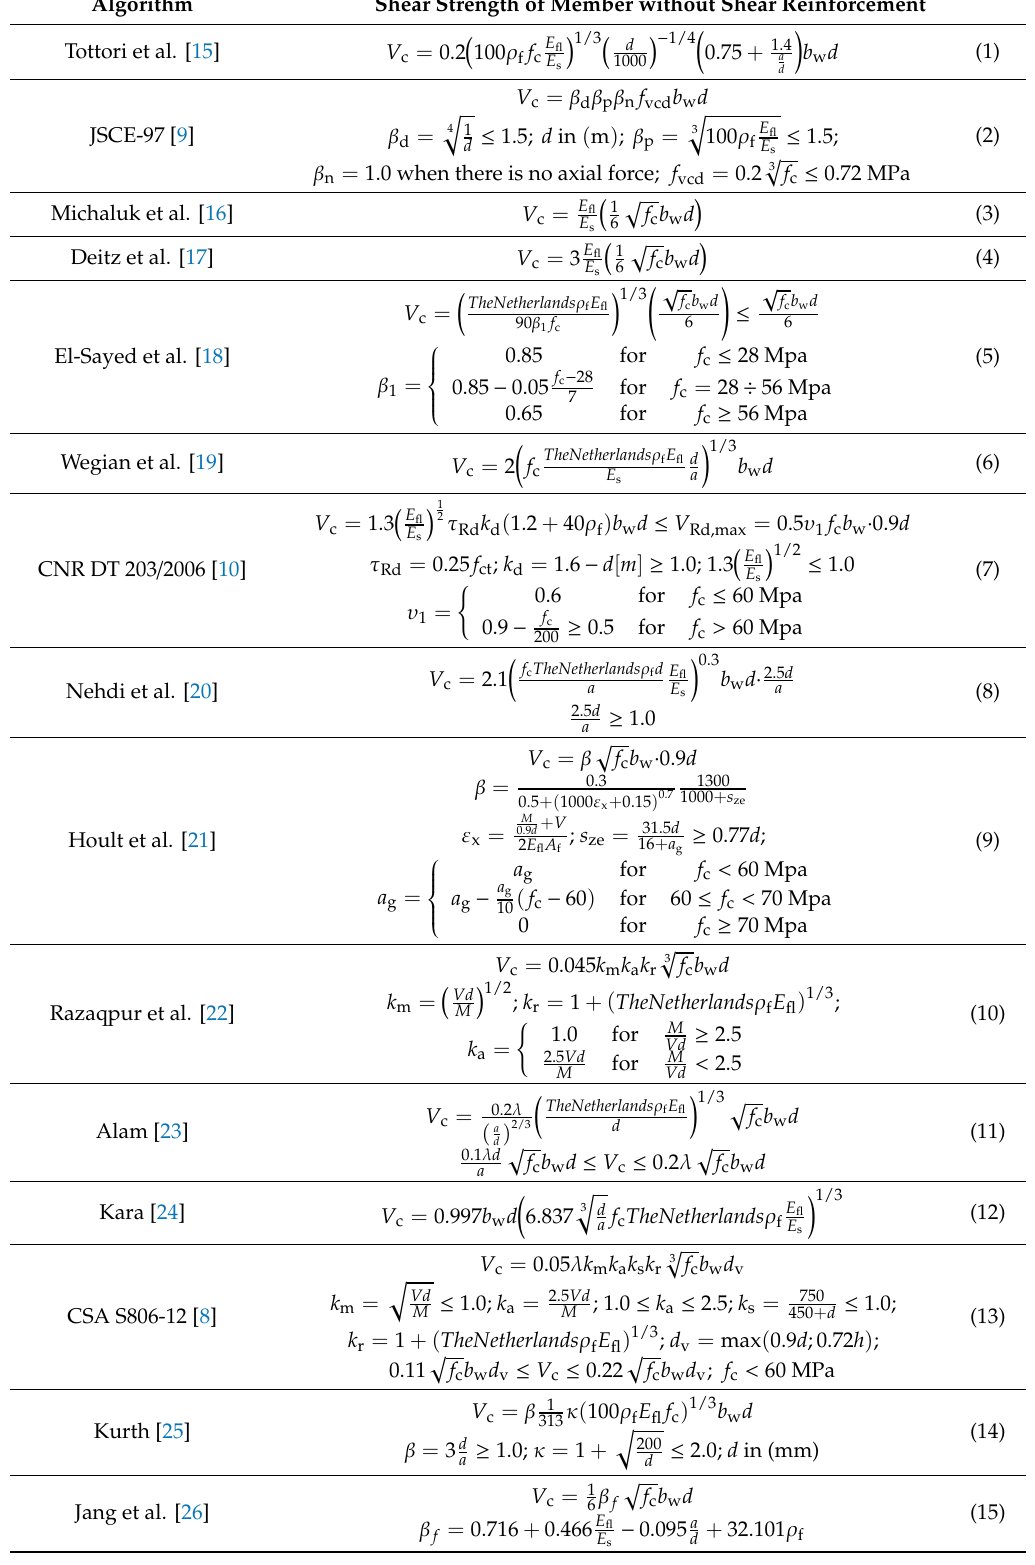
Table 1. Algorithms for determining the shear resistance of the shear zones longitudinally reinforced with fibre-reinforced polymer (FRP)